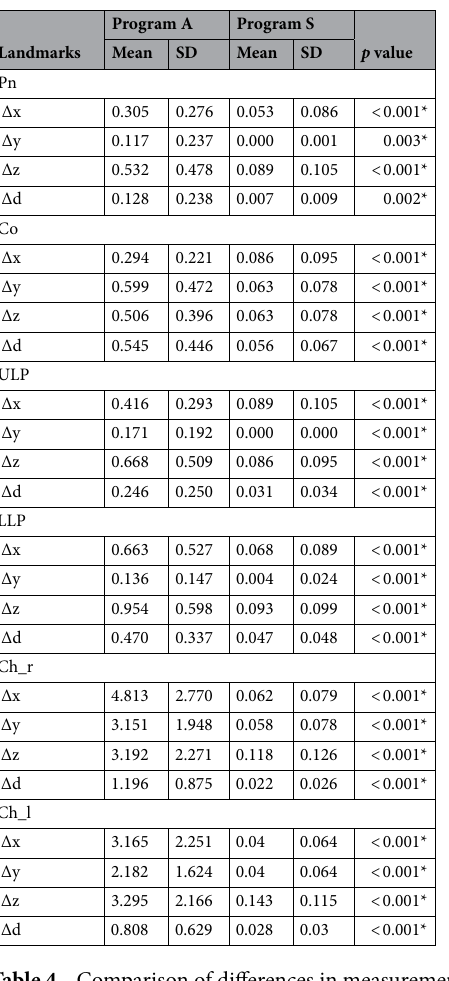
Table 4. Comparison of differences in measurement values (Δx, Δy, Δz, Δd) between the two examiners. Data are presented as p value calculated with paired t-test between differences in measurement values (Δx, Δy, Δz, Δd (mm)) between examiner 1 and 2 when measured using each program. Pn, Pronasale; Co, Columella; ULP, Upper lip point; LLP, Lower lip point; Ch_r, Cheek right; Ch_l, Cheek_left. SD, standard deviation; * p value <